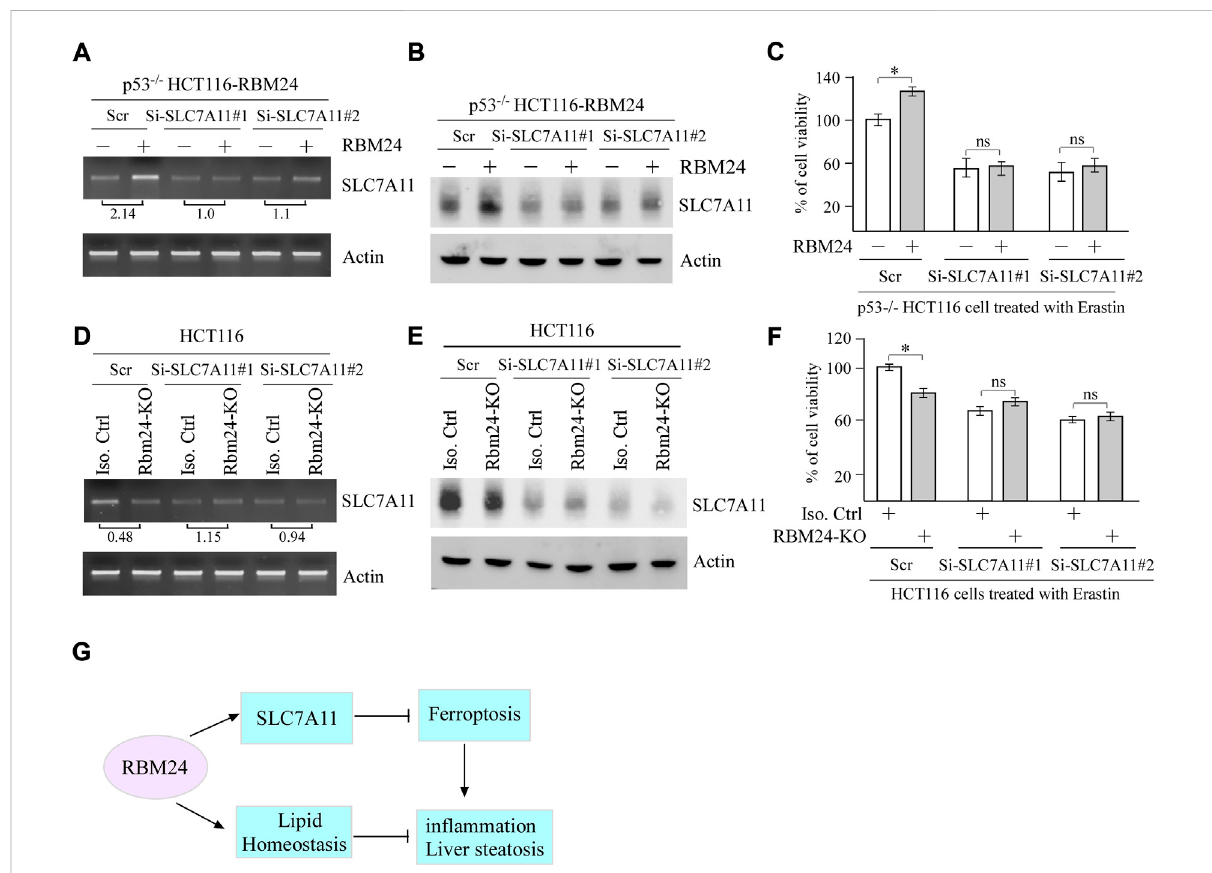
FIGURE 5 SLC7A11 is required for RBM24-mediated suppressionofferroptosis. (A,B) p53 − / − HCT116 cellswere transiently transfectedwith ascrambled or SLC7A11 siRNA for 2 days, uninduced or induced to express RBM24 for 24 h, followed by Erastin treatment for 8 h. Both RT-PCR and western blot analyses were performed to measure the levels of SLC7A11 and actin mRNAs (A) and proteins (B) , respectively. The relative fold change of SLC7A11 transcript was shown below the lane (C) p53 − / − HCT116 cells were treated as in (A) , followed by cell viability assays. The experiments wereperformedintriplicates (D,E) IsogeniccontrolandRBM24-KOHCT116cellsweretransientlytransfectedwithascrambledorSLC7A11siRNAfor 3days,followedbyErastintreatmentfor8 h.ThelevelsofSLC7A11andactinmRNAs (D) andproteins (E) weremeasuredbyRT-PCRandwesternblot analyses, respectively. The relative fold change of SLC7A11 transcript was shown below the lane. (F) HCT116 cells were treated as in (D) , followed by cell viability assay. The experiments were performed in triplicates. (G) A proposed model for the role of RBM24 in modulating in fl ammation and liver steatosis by regulating SLC7A11 and lipid